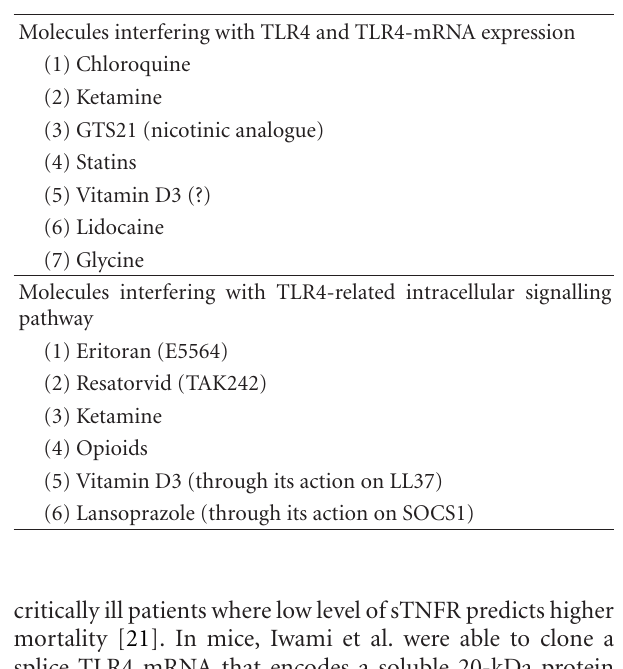
Table 2: Mode of action of various molecules targeting